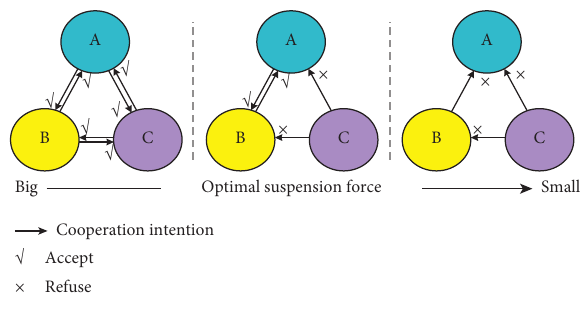
Figure 12: Change in agents’ cooperation intentions.